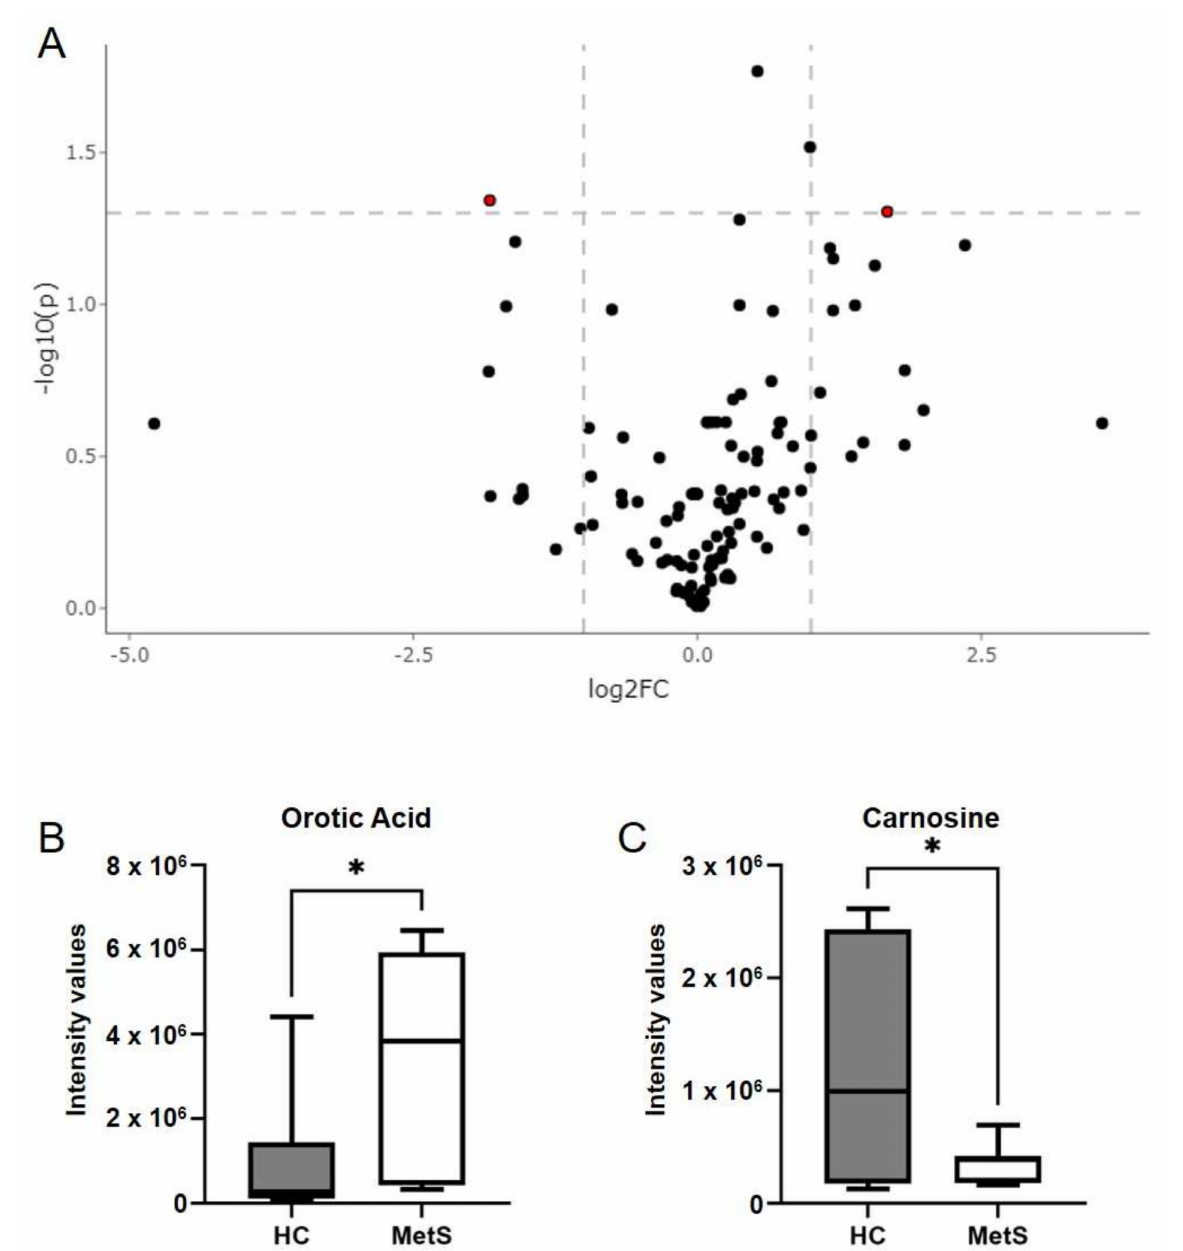
Figure 4. Hybrid metabolomics of stool samples. ( A ) Volcano plot from hybrid LCMS assays of stools from MetS and HC subjects ( n = 7–10/group) depicting a standard panel of approx. 150 polar metabolites. Each dot represents one metabolite, dashed lines indicate default thresholds for signifi- cance ( p < 0.05) and fold change up- or down-regulation by 2-fold ([Log2FC] = 1). The red dot on the right represents a metabolite with higher levels in MetS participants, while the dot on the left is a metabolite with lower levels in MetS in respect to HCs. Plot showing the intensity values of fecal ( B ) orotic acid and ( C ) carnosine in MetS and HC participants. Plots indicate median ( ± minimum and maximum). * p < 0.05. Two-tailed unpaired Student’s t